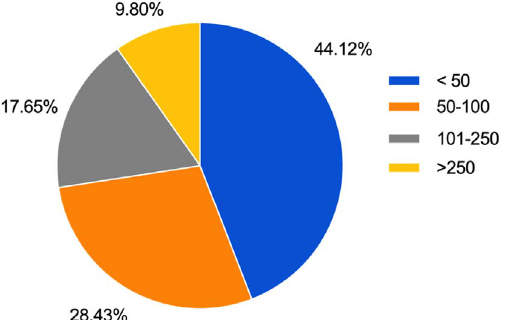
Figure 5. Results of the survey question: How long after the index TKA would you perform MUA? N/A indicates surgeons who would choose not to perform MUA for stiffness following